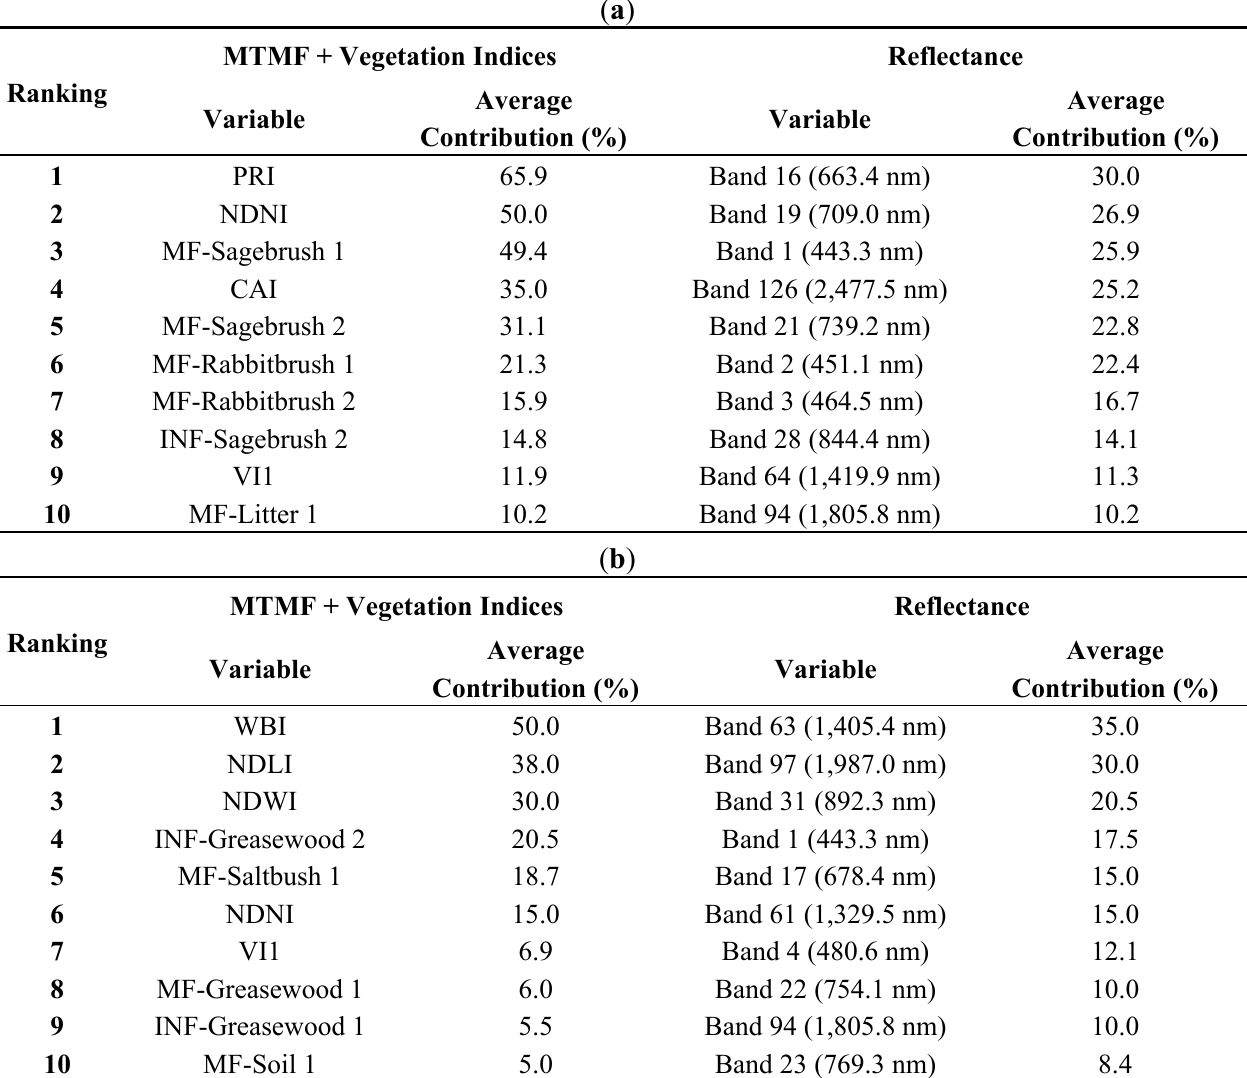
Table 4. Key input variables to the decision trees classifications: ( a ) for the Monticello site, and ( b ) for the Monument Valley